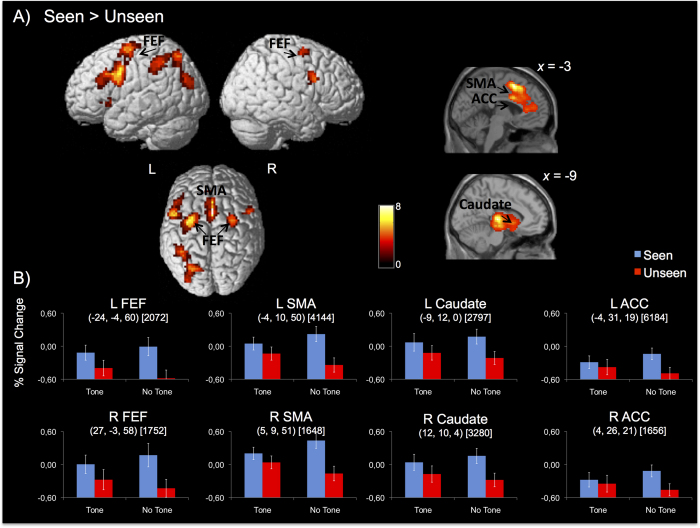
(A) Brain renderings showing activations for the Seen > Unseen whole-brain contrast (p < 0.05, FWE cluster-level corrected). (B) Percent (%) signal change from functionally identified ROIs as a function of Awareness, Alerting State, and Validity, showing a significant Alerting State x Awareness interaction (Table 2). All regions demonstrated increased % signal change for seen as compared to unseen reports, which was enhanced when the alerting tone was not presented. The center of mass of each ROI is indicated in parenthesis, and the volume in mm is indicated in squared brackets. The following ROIs were also analyzed and demonstrated no significant effects: Left IPL (−38, −48, 45) [6152], left SPL (−24, −67, 51) [3408], left thalamus [(−11, −18, 6) [7792] and right thalamus (11, −16, 7) [5032]].